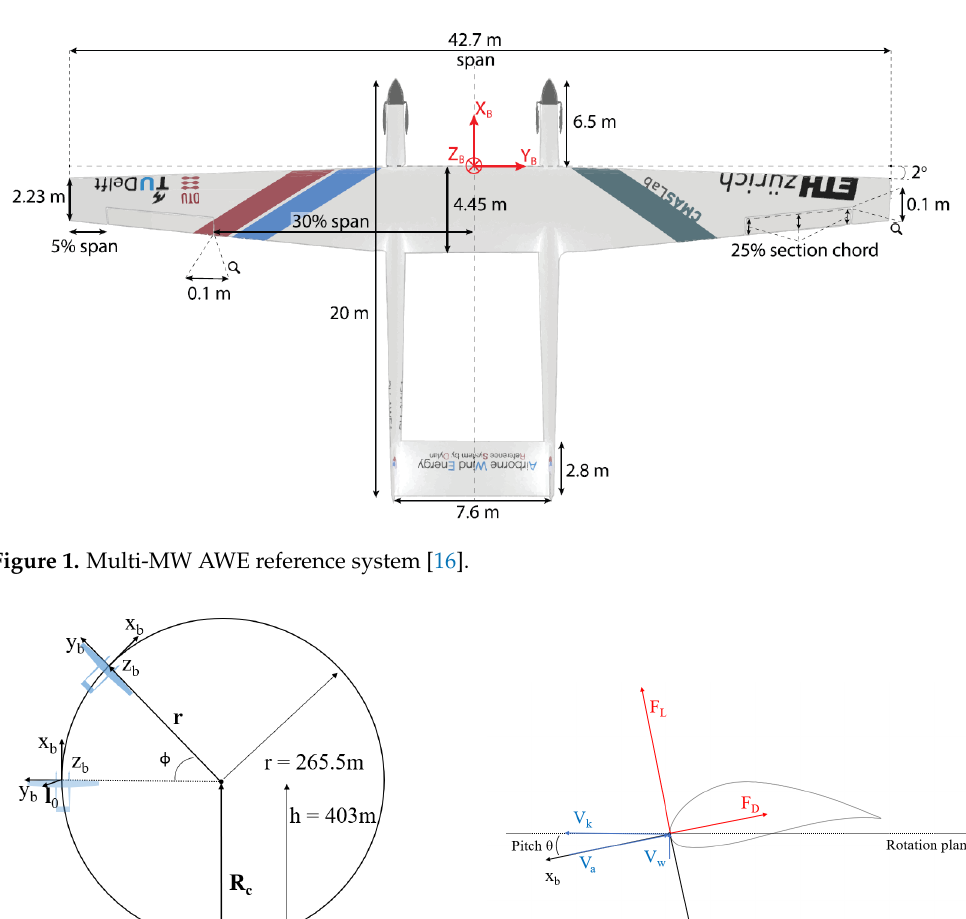
Figure 2. ( left ) Visualization of the prescribed flight path [21], chosen such that the aircraft operates under perfect crosswind conditions, similar to the blade of a wind turbine. ( right ) Visualization of aircraft attitude and